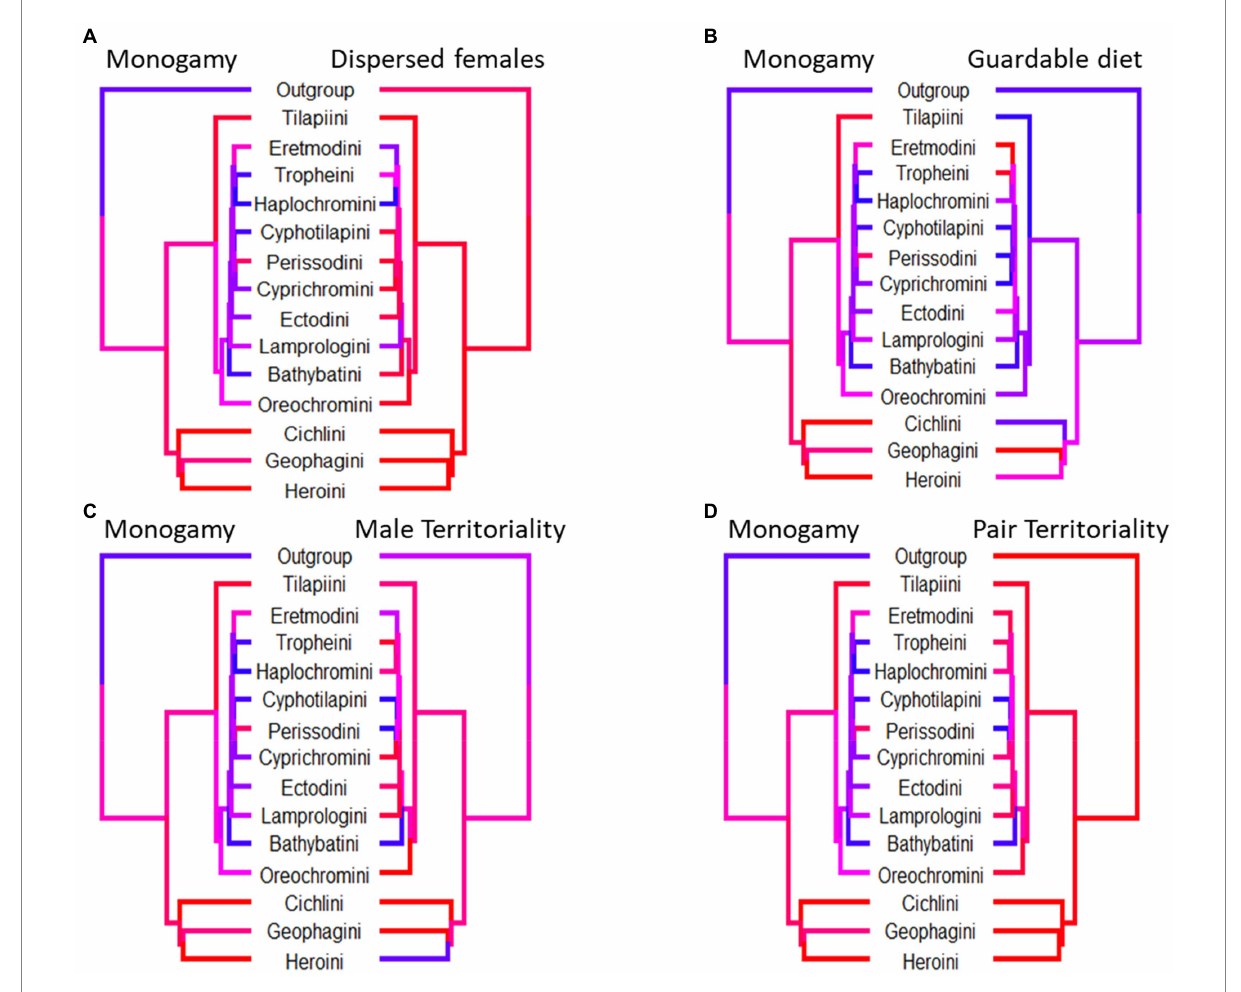
FIGURE 3 Phylogenetic trees where each tip corresponds to a tribe of cichlid fishes. Tip and branch colours correspond to the proportion of species with data present in the tribe which display the trait, with red corresponding to a value of 1, blue to a value of zero. For each tree we only included species which had data present for either trait and not all trees contain the same tribes. Although all paired traits evolve dependently with each other, the coincidence of monogamy and its paired trait differs. (A) Monogamy is slightly more prevalent in tribes with dispersed females. (B) Highly monogamous tribes are also slightly more likely to not have a diet of guardable food. (C) There is no clear pattern between the high incidence of monogamy and male territoriality across cichlid tribes. (D) Highly monogamous tribes are likely also tribes with a high incidence of female